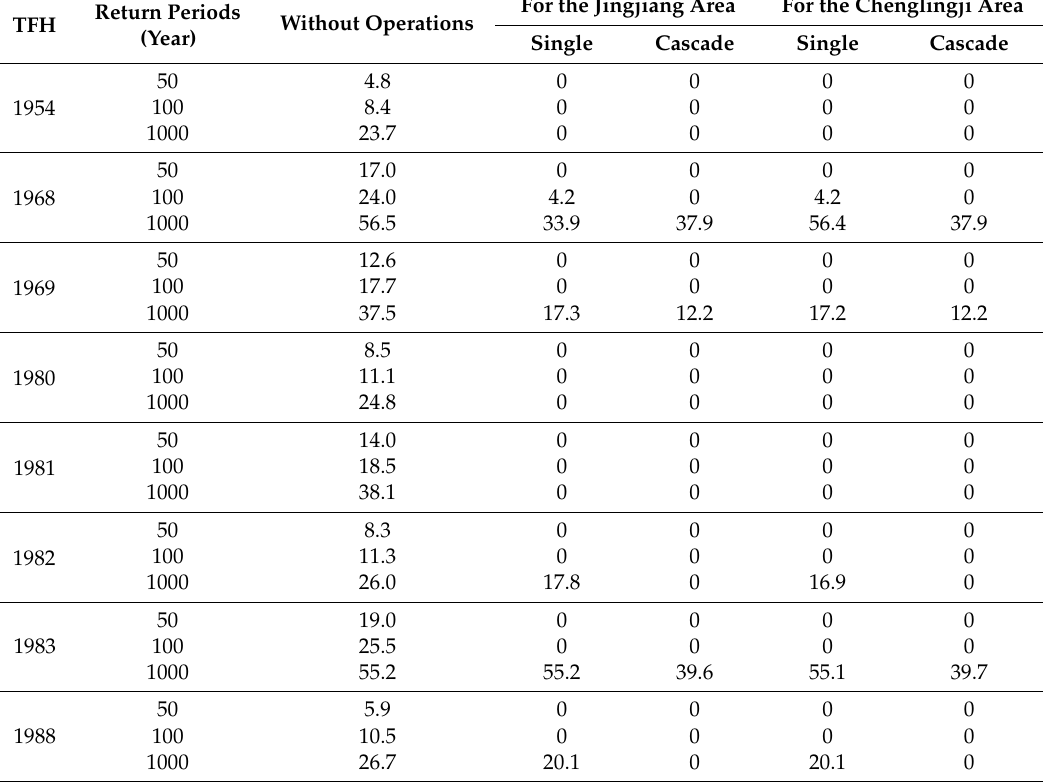
Table 4. Flood diversion volumes of each design flood hydrograph (DFH) at the Jingjiang flood control point (billion m 3